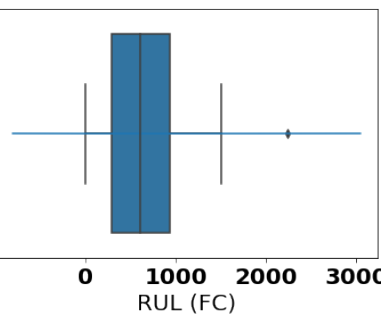
Figure 14. The mean RUL for all trajectories of the cooling unit